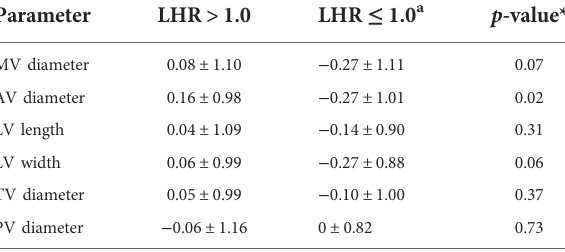
TABLE 3 The relationship of low lung-to-head ratio ( ≤ 1.0) and cardiac structure z-scores, based on CDH-speci fi c prediction equations. Parameter LHR >